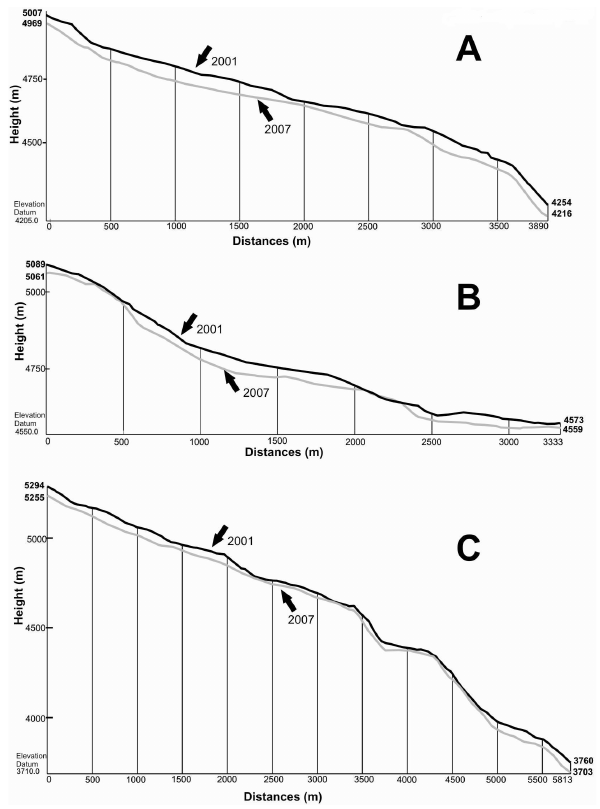
Fig. 3. Ice surface elevation of Las Vacas Glacier in 2001 and 2007. (A) Las Vacas Glacier profile #1. (B) Las Vacas Glacier profile #2. (C) Las Vacas Glacier profile #3.